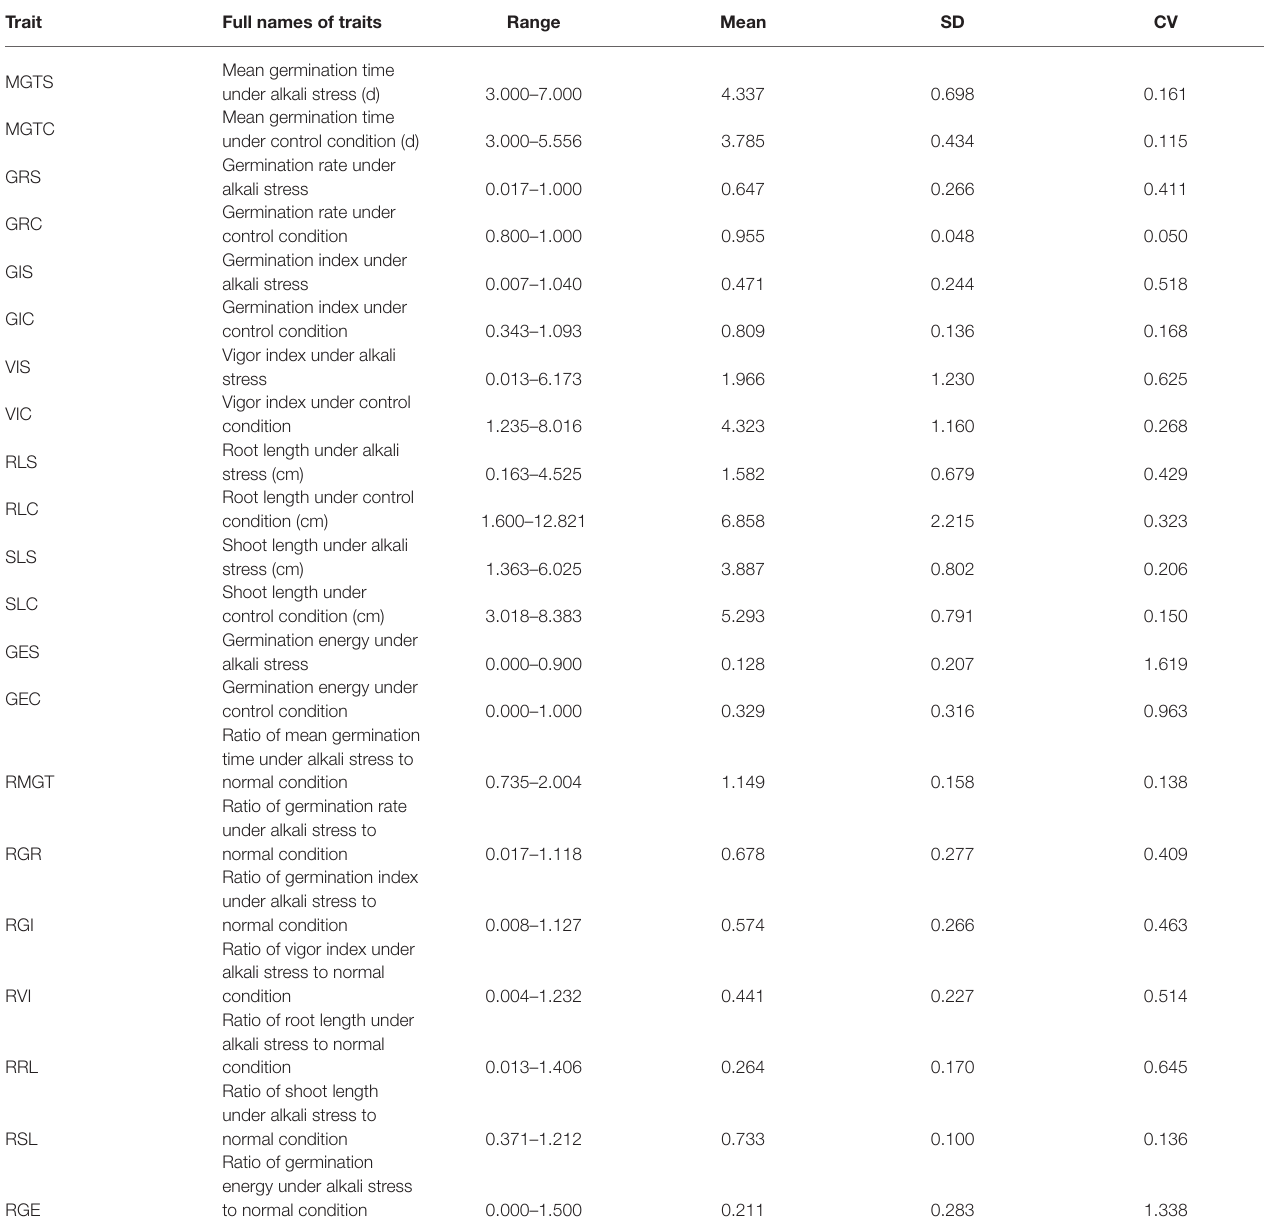
TABLE 1 | Summary of the 21 traits measured in this study.